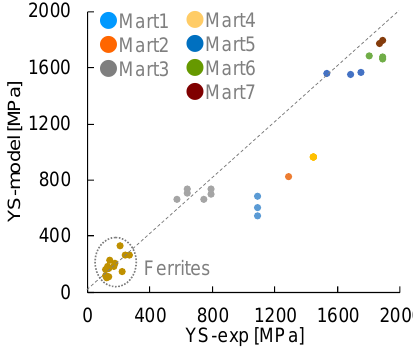
Figure 10. Model-Experiment plot of the yield